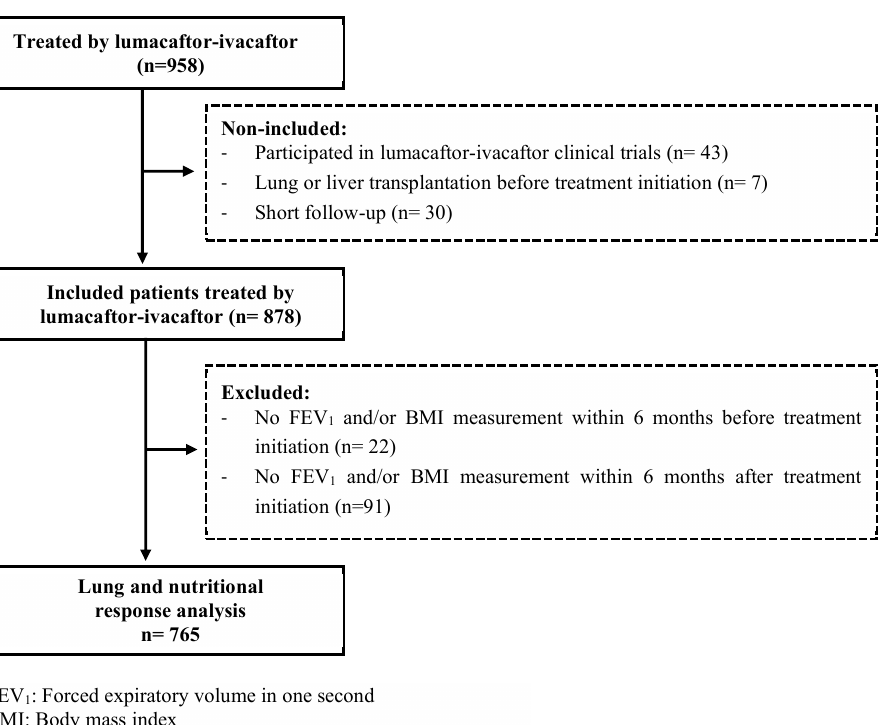
Figure 1. Flowchart of patient selection. Flowchart describing the selection of people with cystic fibrosis included in the analysis of the lung and nutritional response to combined lumacaftor/ivacaftor therapy.